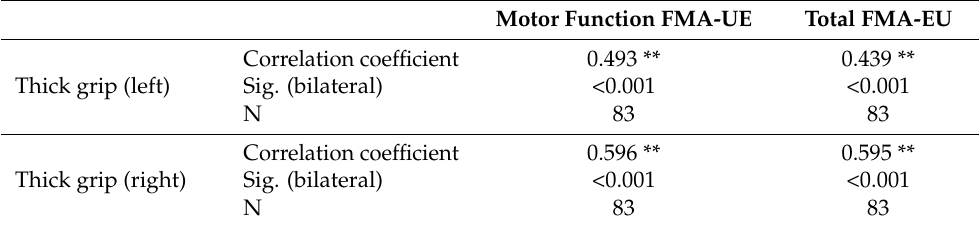
Table 2. Pearson ARAT—Fulg–Meyer